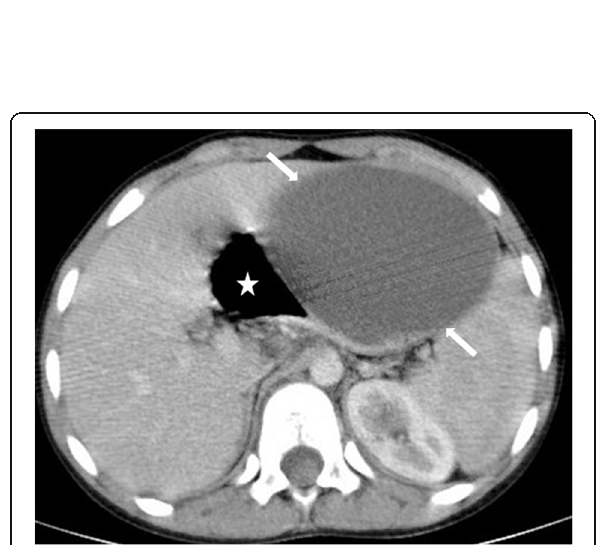
Fig. 29 A 9-year-old female patient with palpable epigastric mass was found to have a large cystic mass in the epigastrium on US examination (not shown). An abdominal CT study was planned for better assessment of the anatomic relationship of this lesion. Axial plane post-contrast CT image shows a huge cystic mass (arrows) compressing and displacing the stomach (star). Surgery confirmed gastric duplication